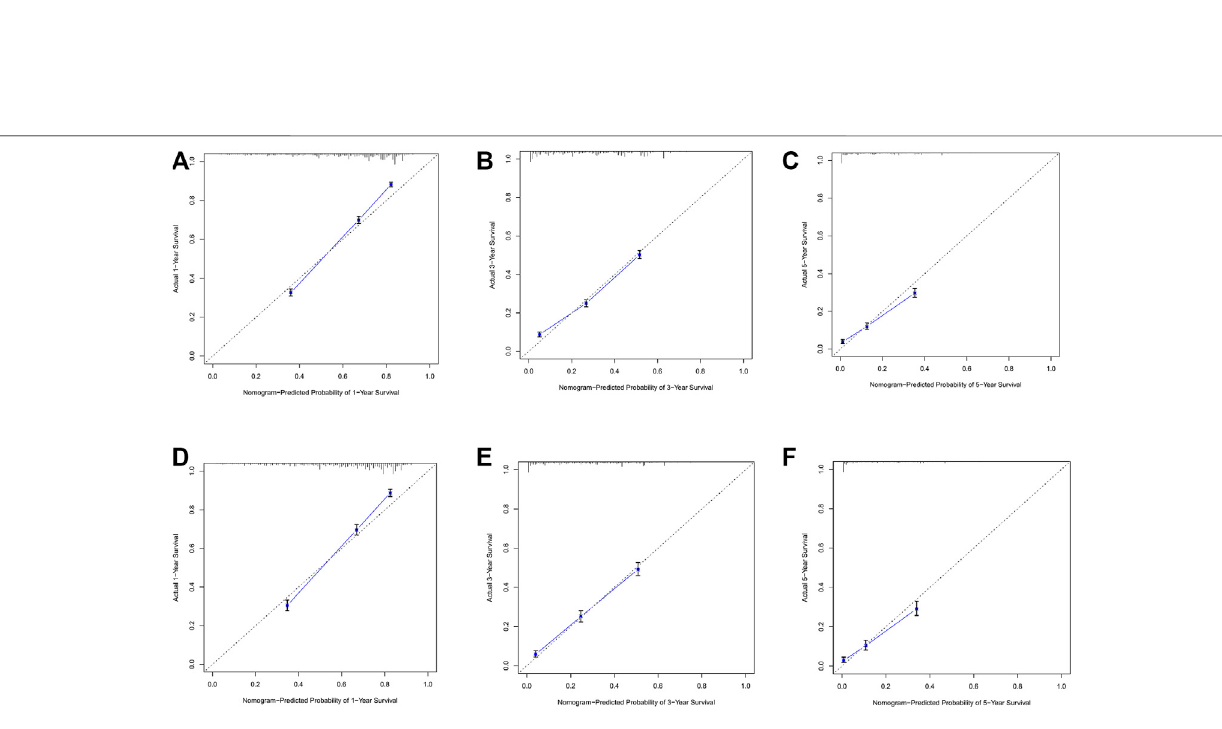
Frontiers in Genetics |